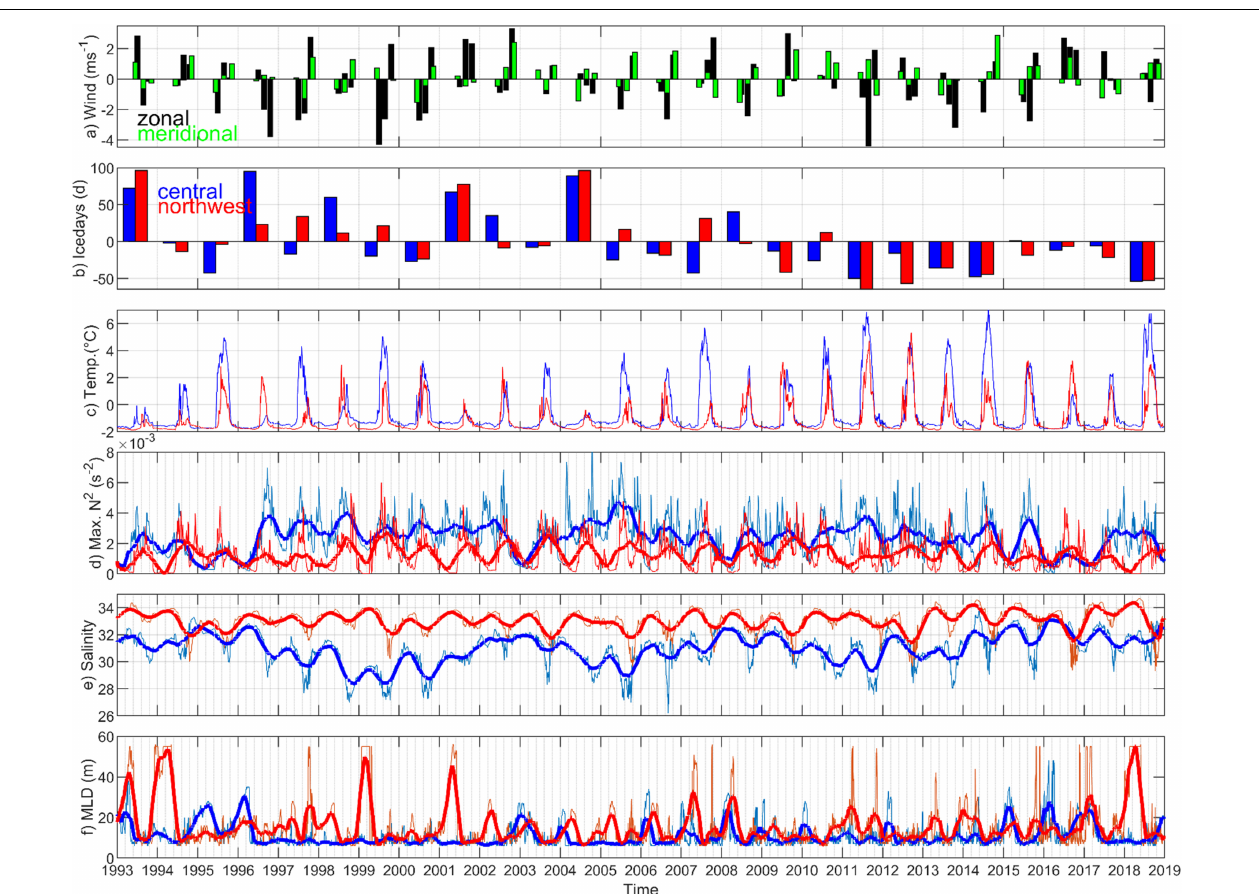
FIGURE 11 | 1993–2019 Mercator record of winds, sea ice and hydrographic parameters. (a) U (black) and V (green) monthly mean July, August, and September ERA-I winds at 73.3 ◦ N, 127.5 ◦ E; (b) Yearly anomalies of days when sea ice was present in concentrations of > 70% on the central Laptev Sea shelf (blue bars) and on the northwestern Laptev Sea shelf (red bars); (c) daily mean upper layer (0–10 m) temperature ( ◦ C); (d) maximum Brunt-Vaisala-frequency N 2 (s - 2 ); (e) mean (surface-to-bottom) salinity; (f) mixed layer depth (m). Note thin lines in (d–f) show daily values, while the thick lines are smooth using a 3 month running mean